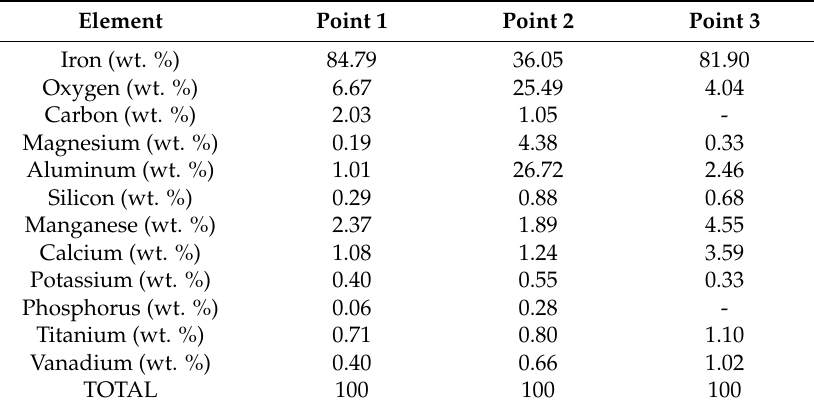
Figure 23. SEM-EDX image (BF1). Table 15. Results of the point analysis